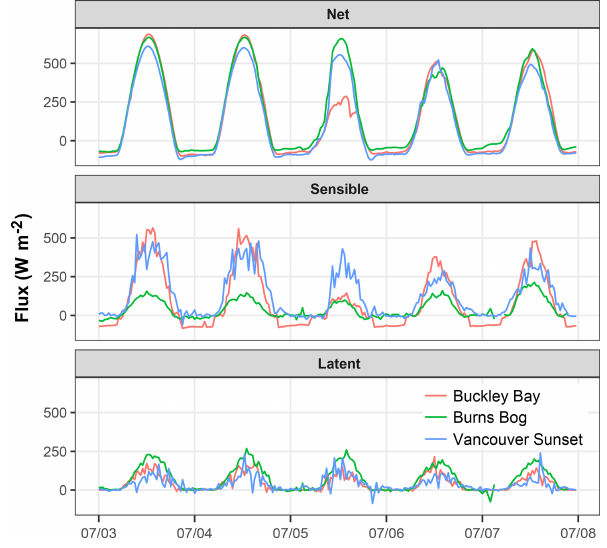
Figure 6. Net radiation ( Q ∗ ) and sensible ( Q H ) and latent ( Q E ) heat fluxes at three sites. Fluxes away from surface are plotted as positive